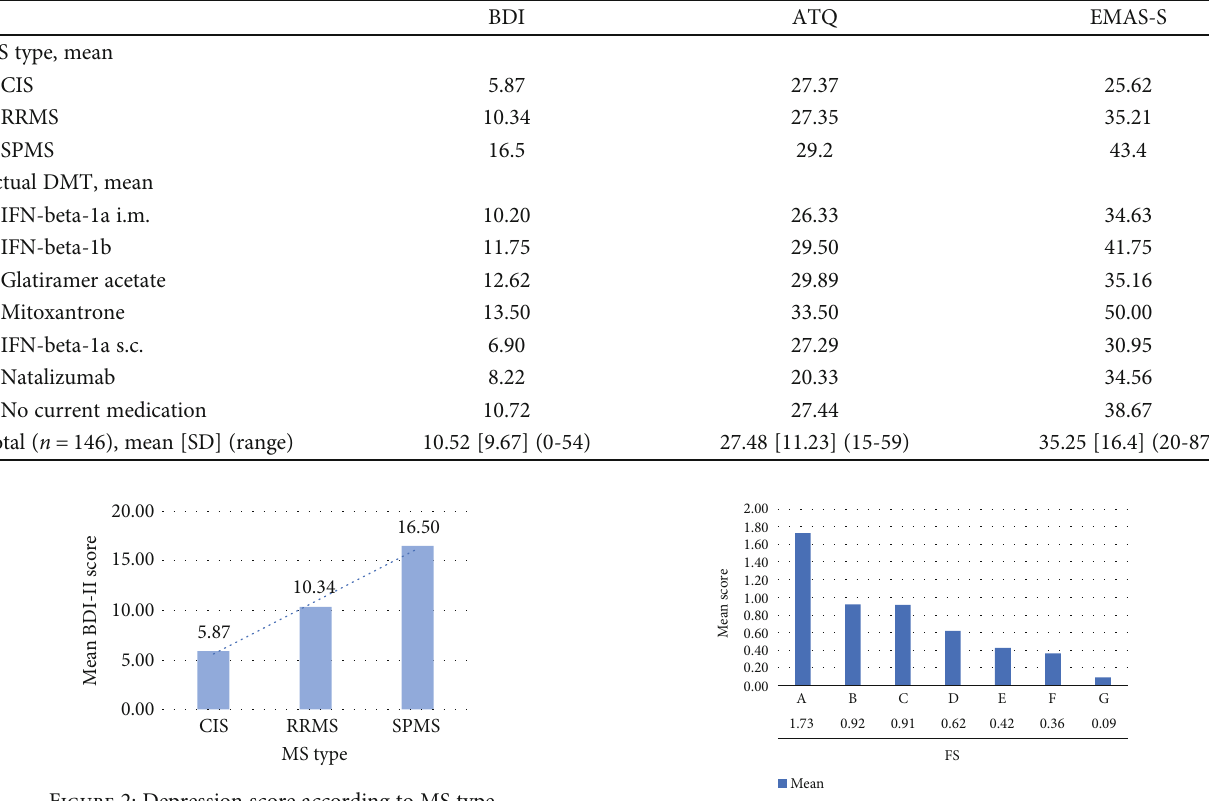
Figure 4: Mean EDSS score for every FS. Table 5: Correlations between every FS of EDSS and psychological